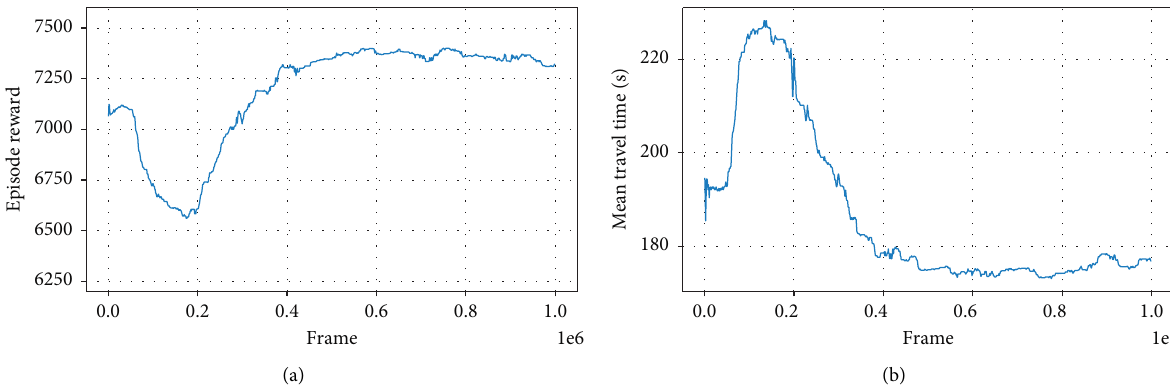
Figure 8: Convergence curves for (a) episode reward and (b) mean travel time.